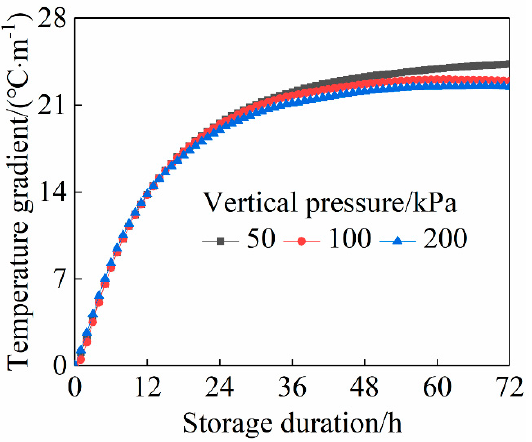
Figure 5. Temperature gradient of bulk grain pile under different